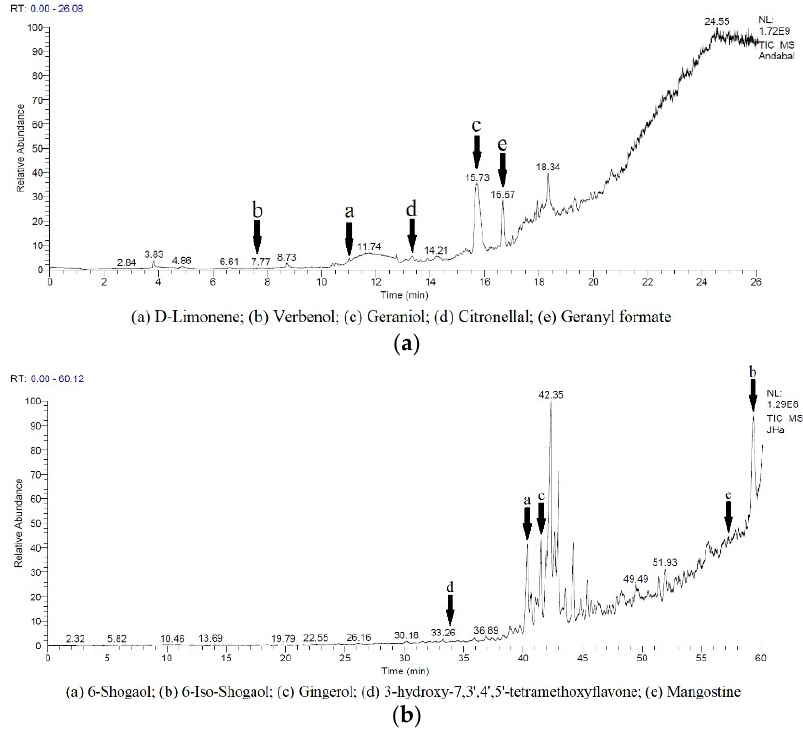
Figure 1. GC/MS chromatograms of lemon pepper ( a ) and black ginger ( b ) extracts. Table 1. Active compounds in lemon pepper and black ginger extracts. Extract Group